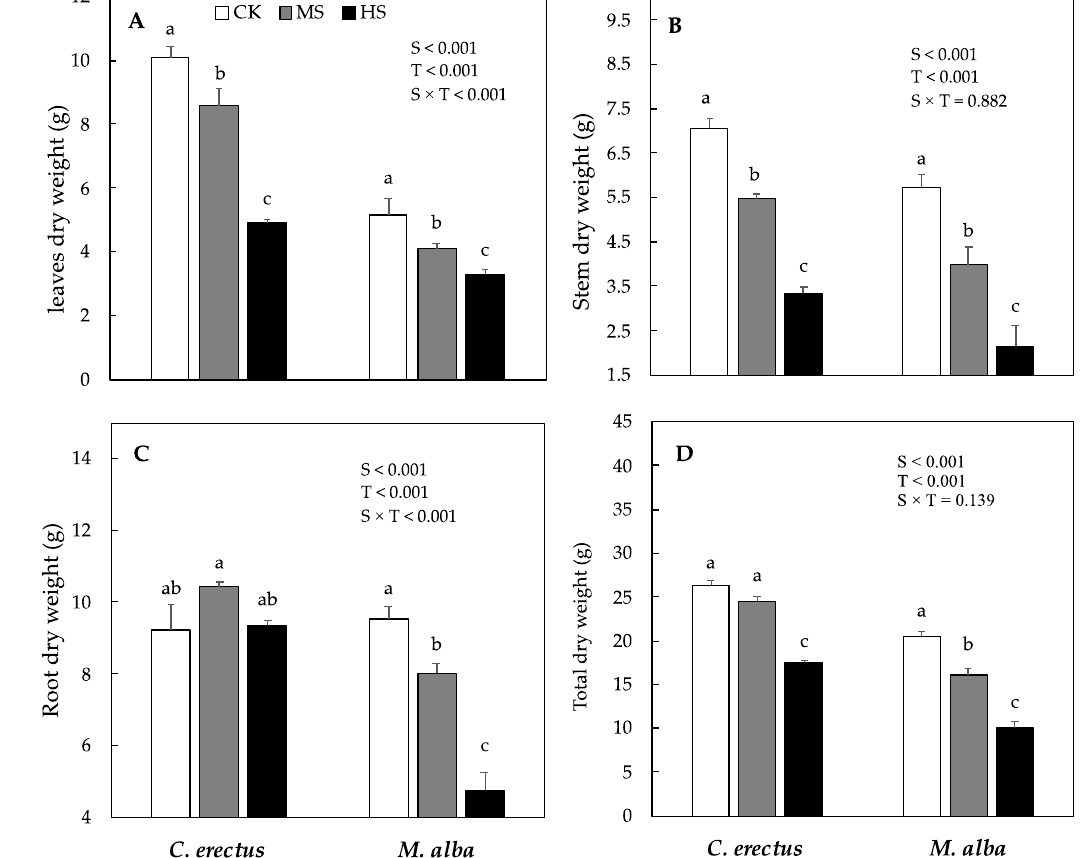
Figure 1. Mean dry weight production in leaves dry weight ( A ), stem dry weight ( B ), root dry weight ( C ) and total dry weight ( D ) under control (CK), Medium (MS) and high (HS) water deficit treatments in C. erectus and M. alba . All the attributes were tested using a two-way ANOVA for species effect (S-effect), treatment (T-effect) and interaction (S × T) effects. All values represent the means ( ± SE) of species in various combinations. Small letters set in bold represent significant difference within each species tested using Dunnett’s test. All the tests were taken significant at p < 0.005.